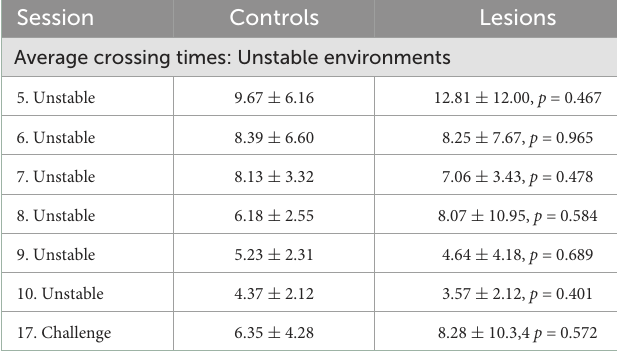
TABLE 6 Average crossing times (seconds) of each group for all sessions with unstable obstacles (mean ± standard deviation, p -values report Student’s unpaired t -test against the control